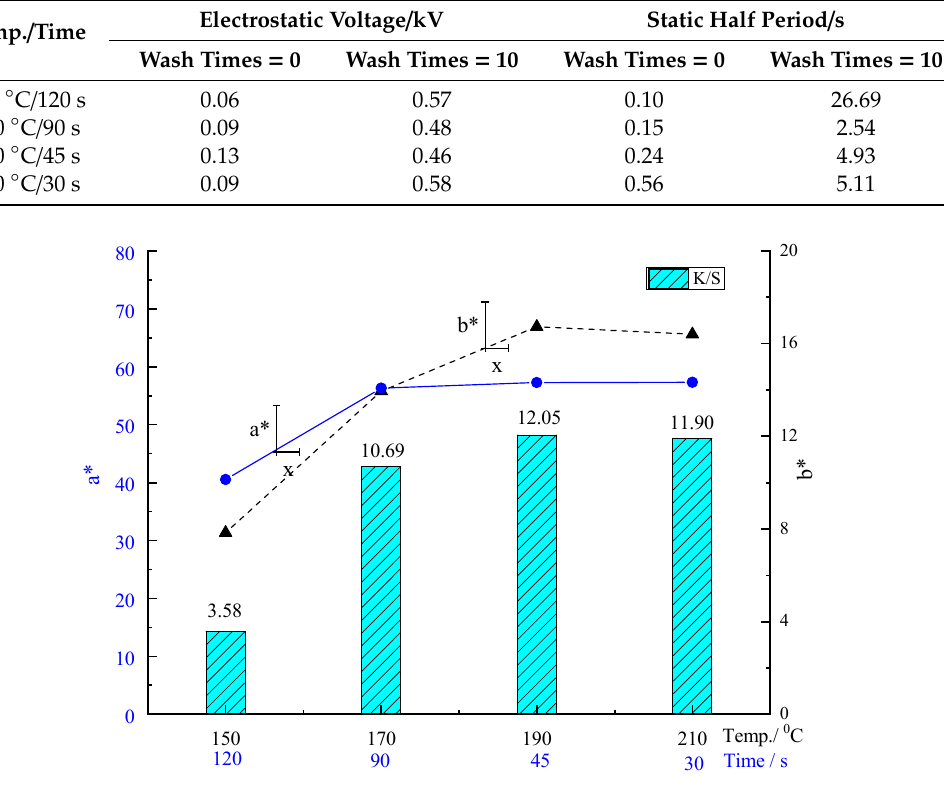
Figure 4. Effect of curing fixation temperature and time on K/S, a* and b* values. Figure 4. E ff ect of curing fixation temperature and time on K / S, a* and b*